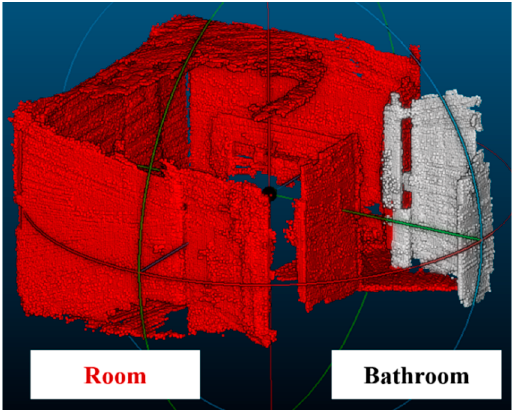
Figure 17. Interference on the ceiling of the bathroom.